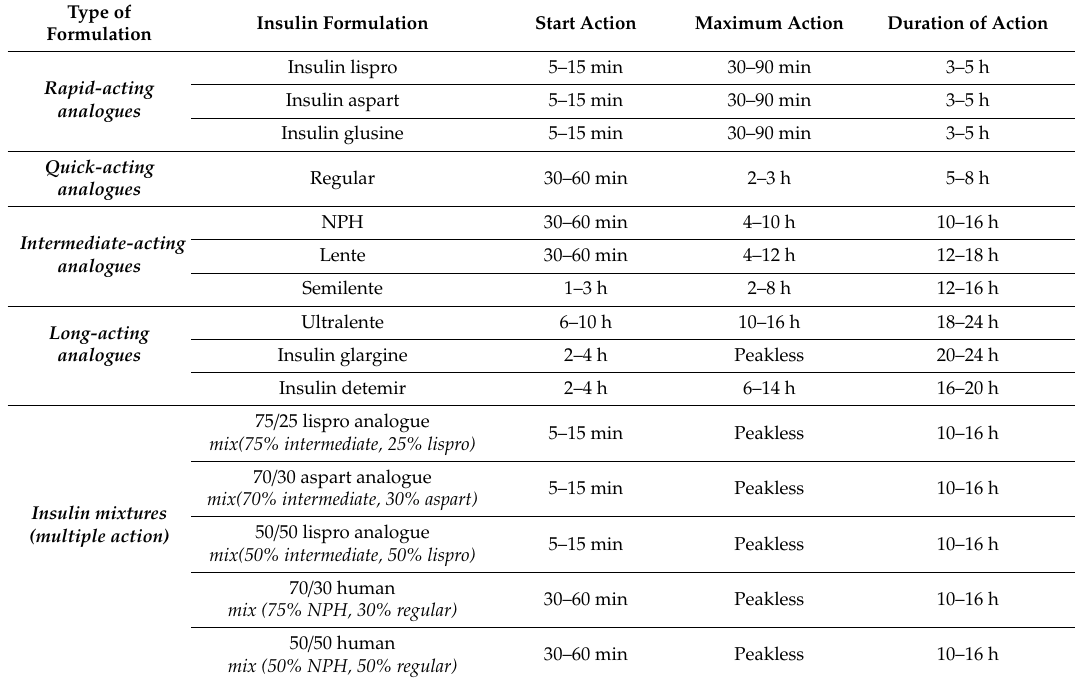
Table 1. Classification of insulin and insulin analogue formulations based on their initiation and duration of action [118].